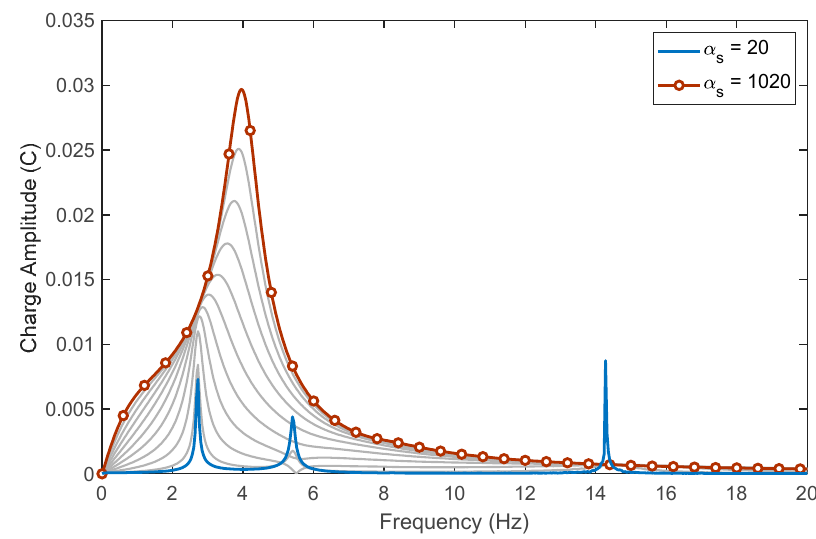
Figure 3. Charge amplitude spectrum at various coupling factors